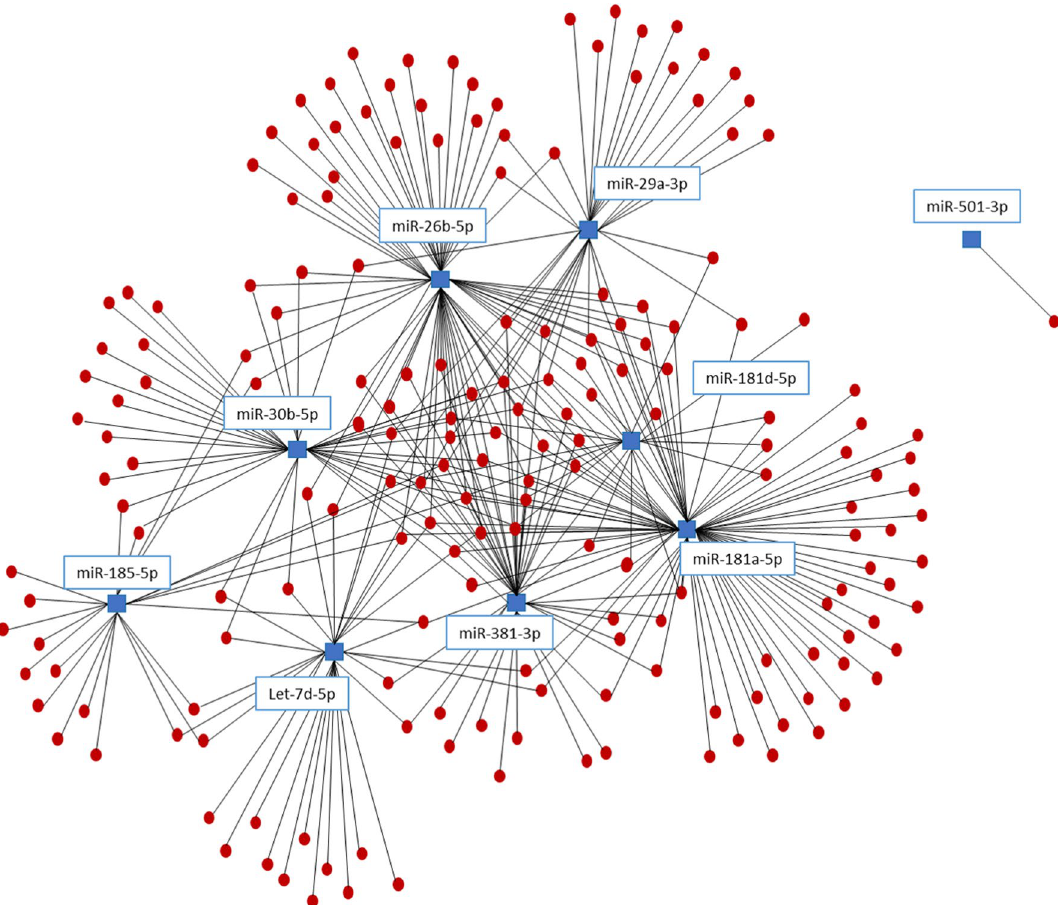
Figure 4. Integrated network of miRNAs and their predicted gene targets which are differentially expressed in small intestinal epithelial cells one day after alcohol and burn injury. miRNA–mRNA interaction network constructed using miRNet containing DEMs (blue squares) and their validated miRNA gene targets which are differentially expressed genes (DEGs) via mRNA sequencing (red